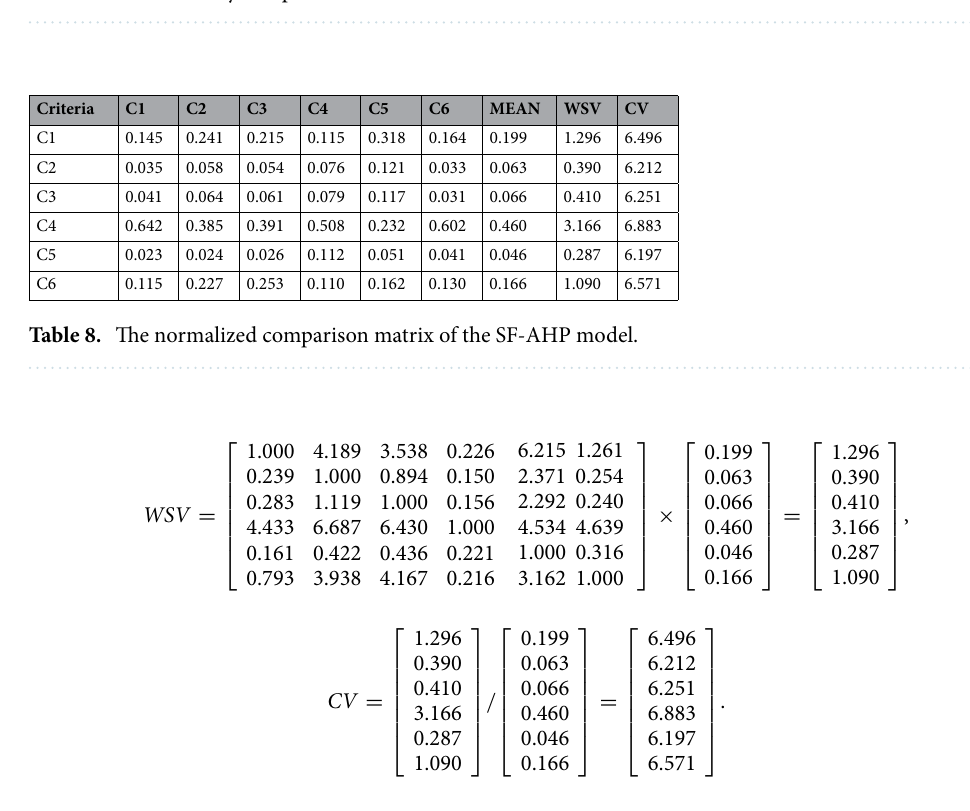
Table 7. The nonfuzzy comparison matrix of the SF-AHP model.